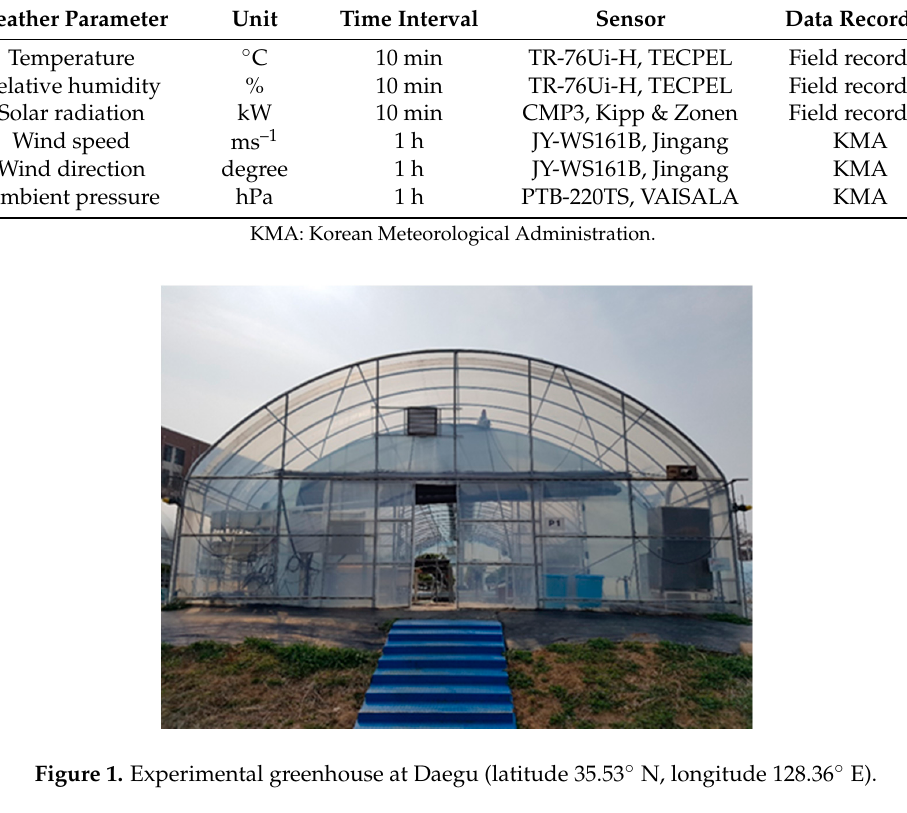
Table 1. Characteristics of the weather data used in the simulations.